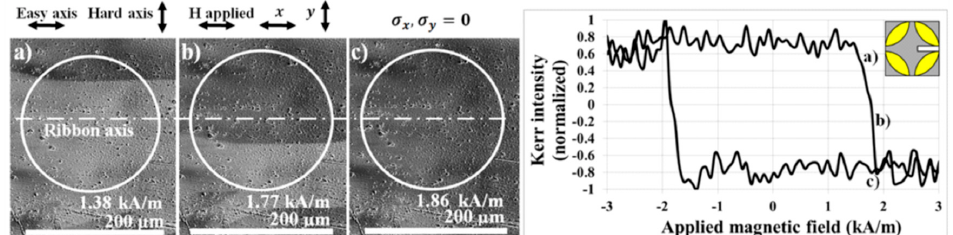
longitudinal magneto-optical Kerr e ff ect in sample (10 × 8) mm 2 without applied tensile stress. Subplots (a), (b), and (c) show magnetic domains corresponding to the reversal of the magnetization